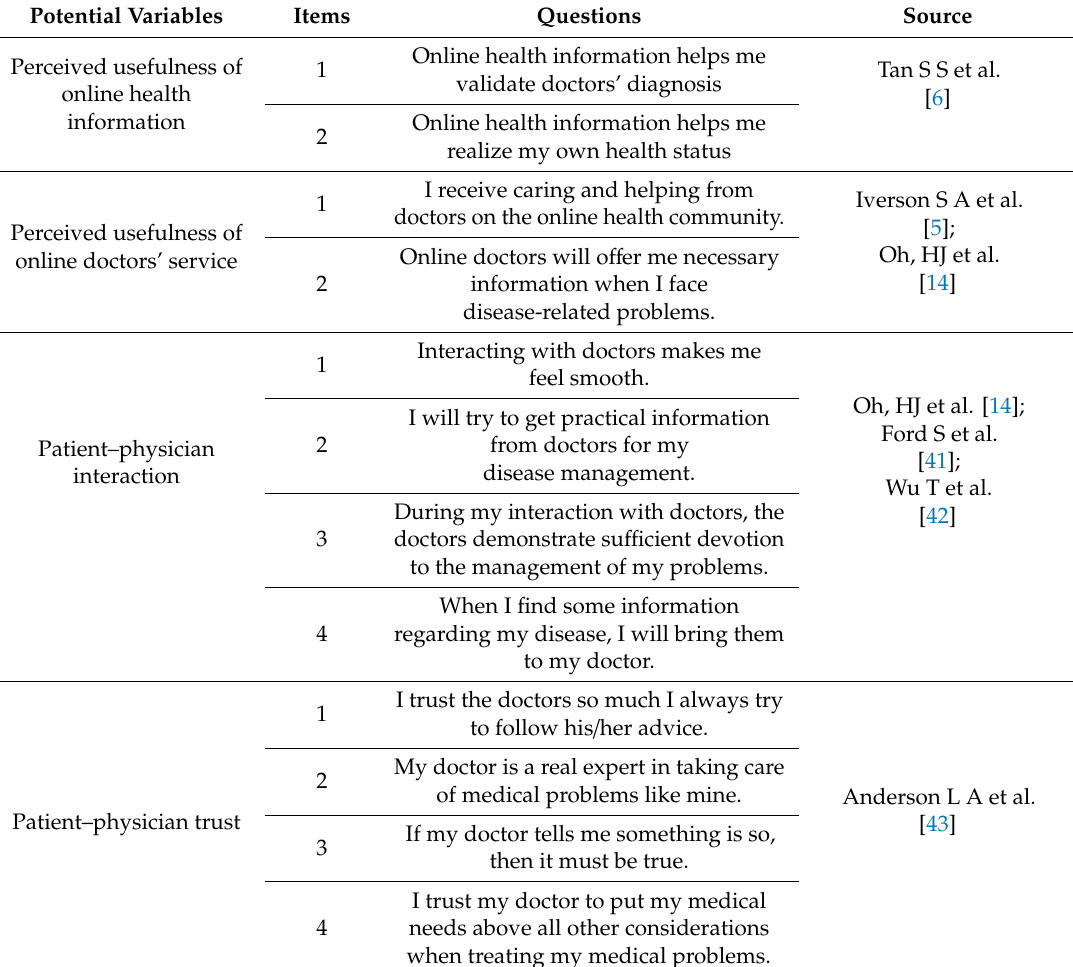
Table 2. Variable measurement and